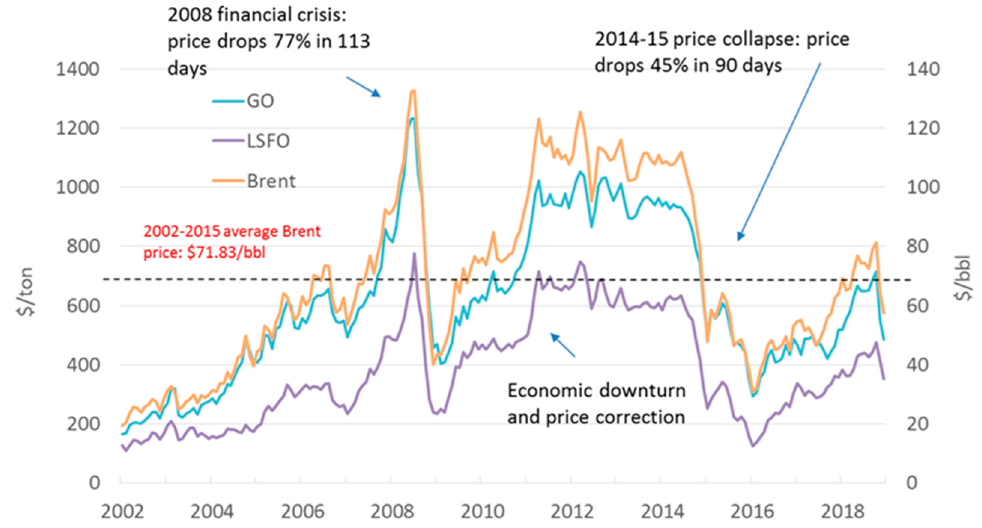
Figure 1. Historic crude oil ($/bbl) and gasoil and low-sulfur fuel oil (LSFO) ($/ton) prices. Source: World Bank.